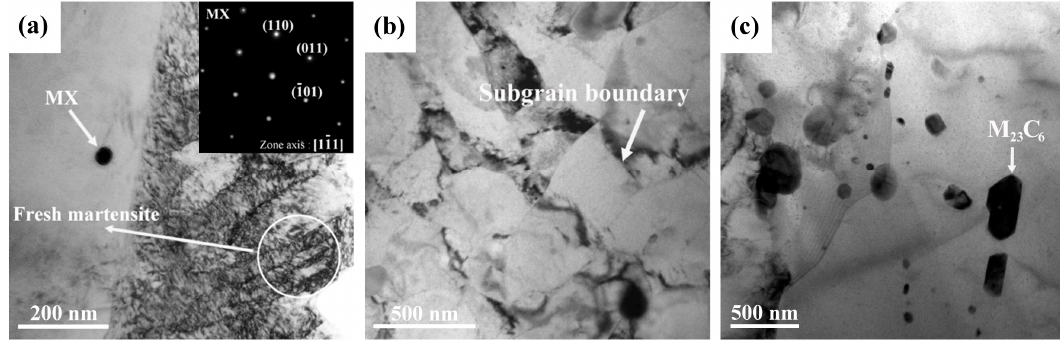
Figure 6. TEM micrographs of the ICHAZ specimen in the: ( a ) as-treated and ( b , c ) PWHT conditions.